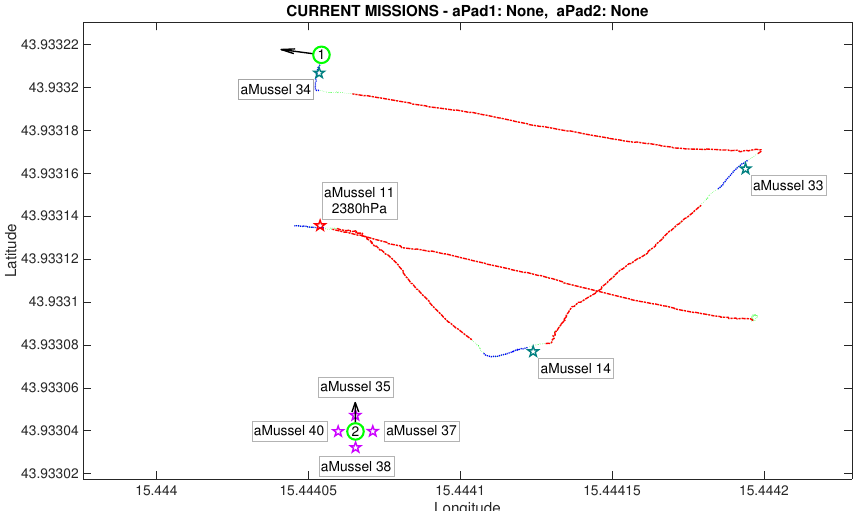
Figure 12. Initial deployment endeded in the Anoxia scenario experiment results from the deployment phase, reconstructed and replayed from recorded vehicle data—Biograd na Moru